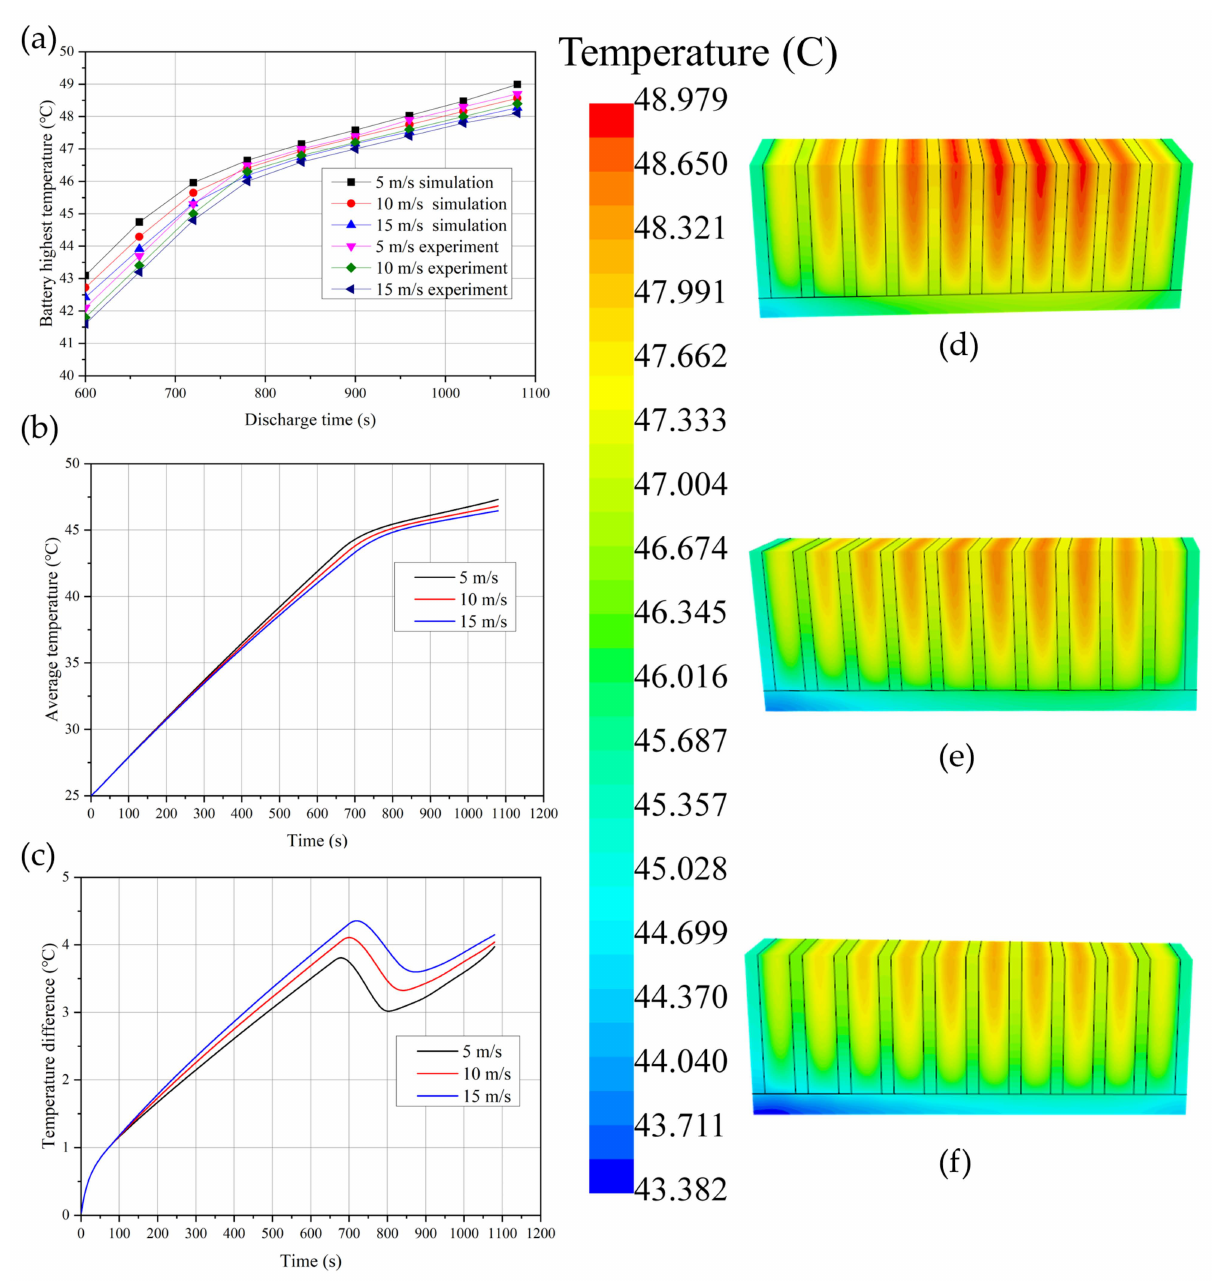
Figure 12. The temperature rise curve of the PCM container coupling forced-air cooling system ( a ) maximum temperature; ( b ) average temperature; ( c ) temperature difference. Temperature field diagram of PCM container coupled forced-air cooling system ( d ) 5 m/s; ( e ) 10 m/s; ( f ) 15